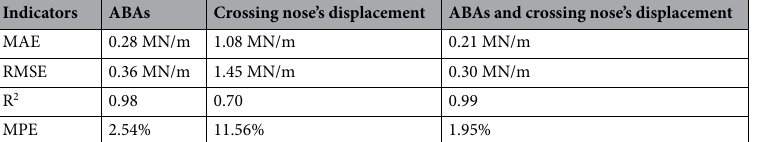
Table 6. Regression model’s